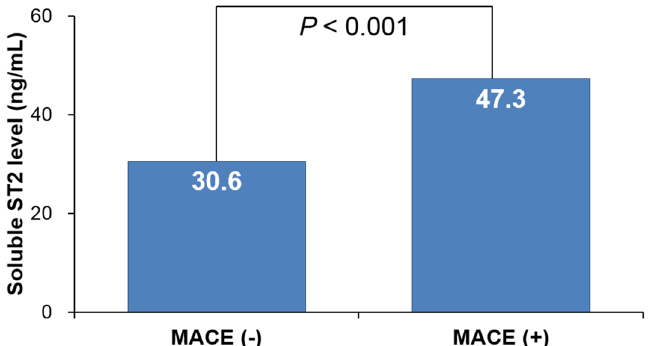
Figure 1. Soluble ST2 levels in patients with and without events. MACE major adverse cardiac event.